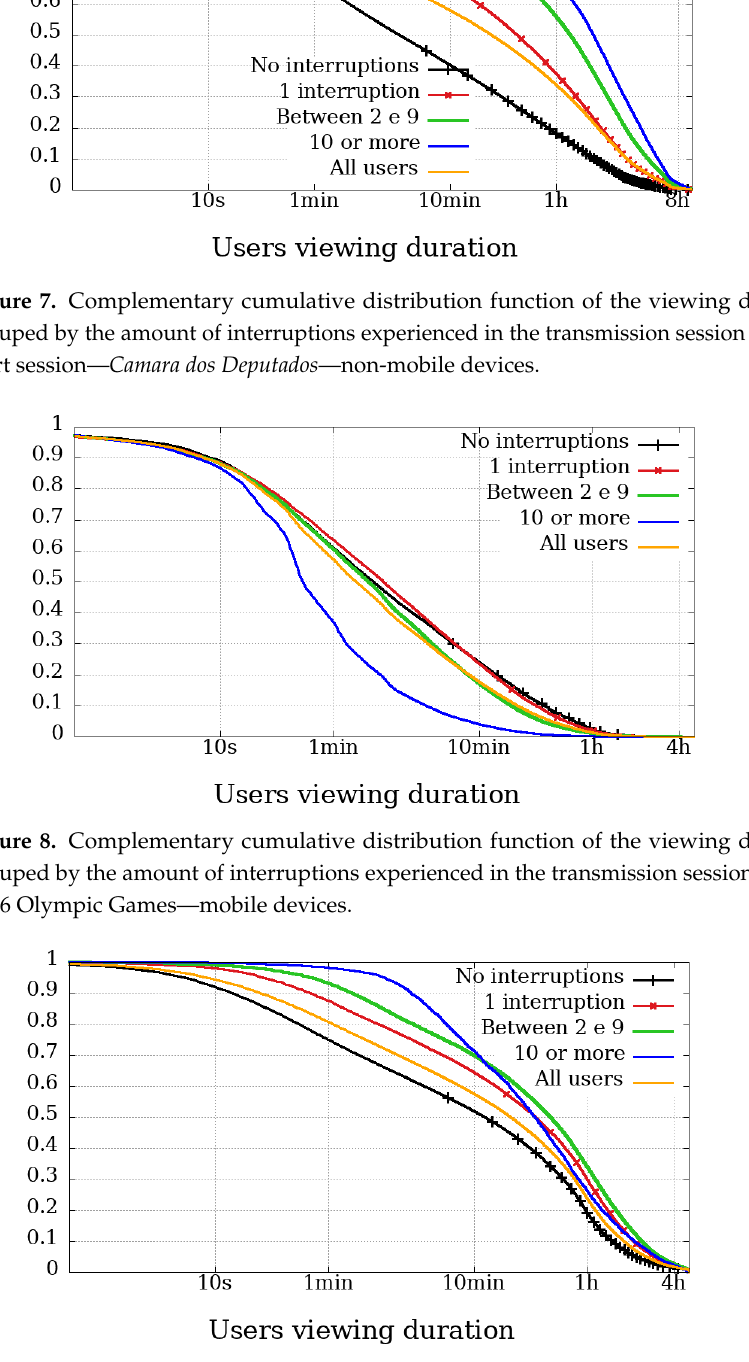
Figure 9. Complementary cumulative distribution function of the viewing duration from users, grouped by the amount of interruptions experienced in the transmission session of the Opening Rio 2016 Olympic Games—non-mobile